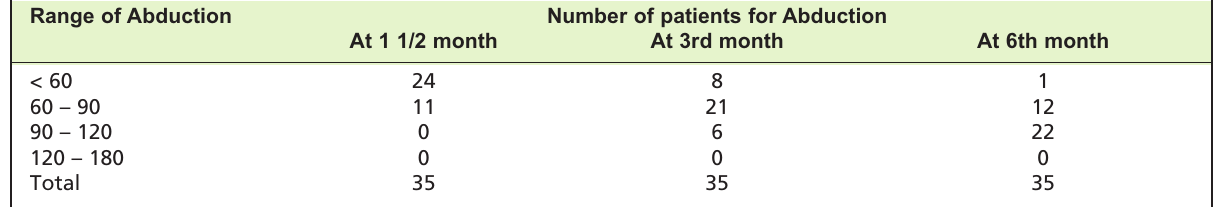
Number of patients in defined abduction range at each follow-up visit Table II: Range of Abduction